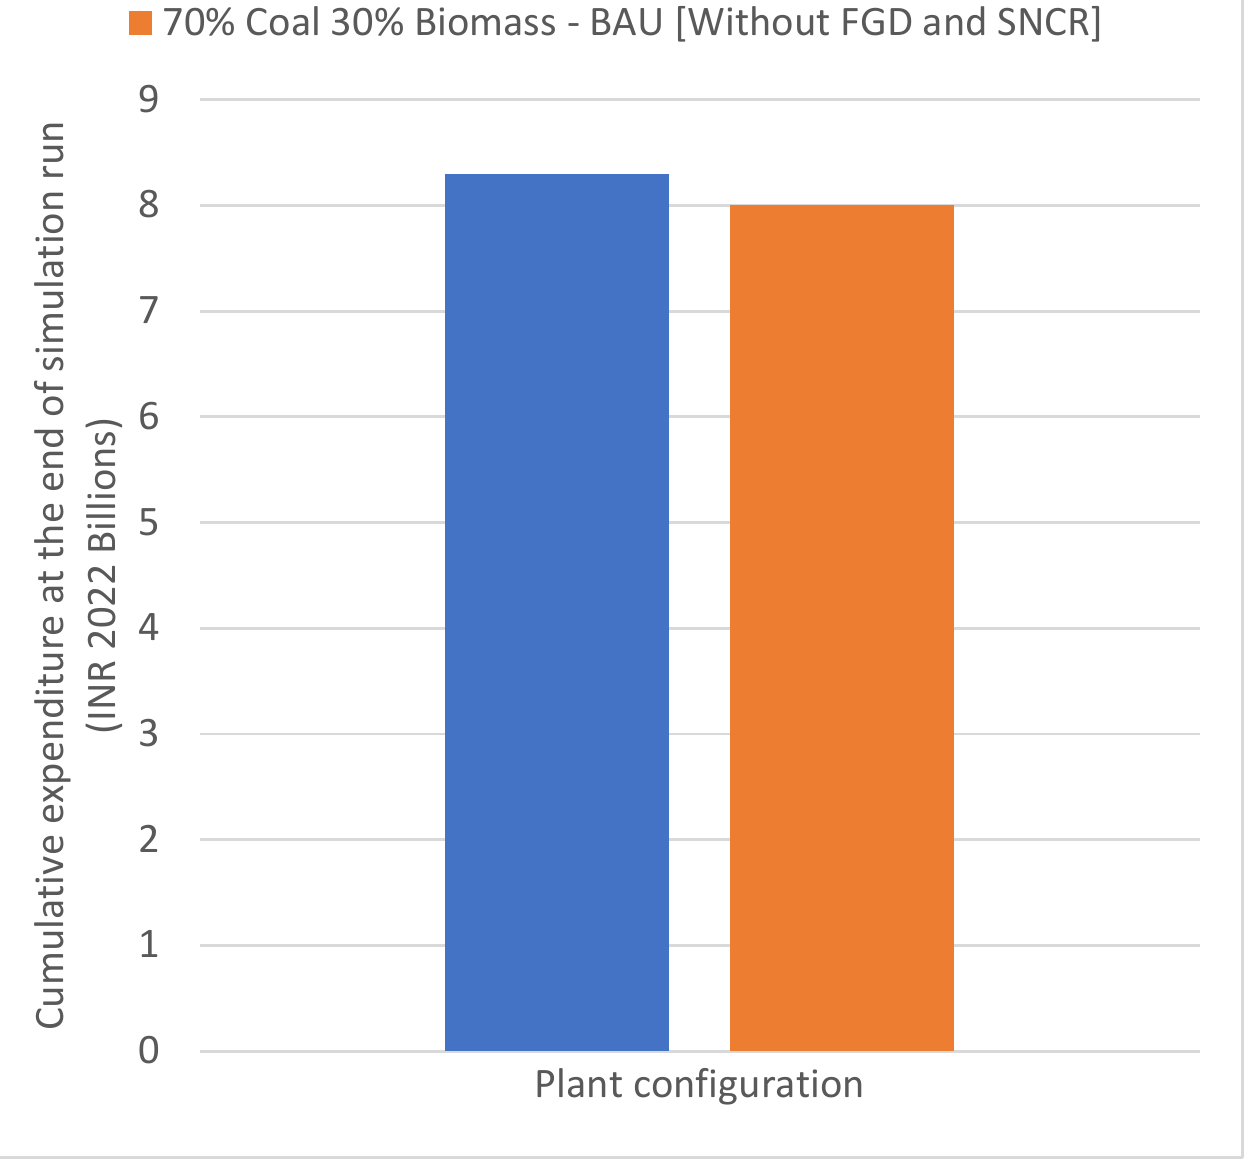
Figure 9. Comparison of cumulative expenditure at the end of the simulation run in BAU scenario, with and without pollution control system.